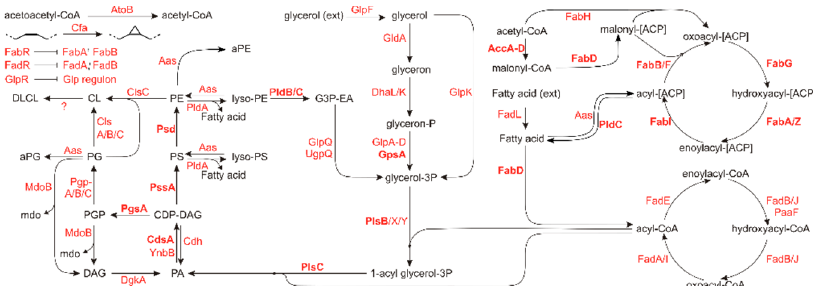
Figure 1. Metabolic scheme of lipid related genes and their role in lipid homeostasis. Genes essential for cell survival and multiplication under generic conditions are shown in bold. Adapted from [29]. Lipid abbreviations: aPE: N-acyl-phosphatidylethanolamine; aPG: O-acyl phosphatidylglycerol